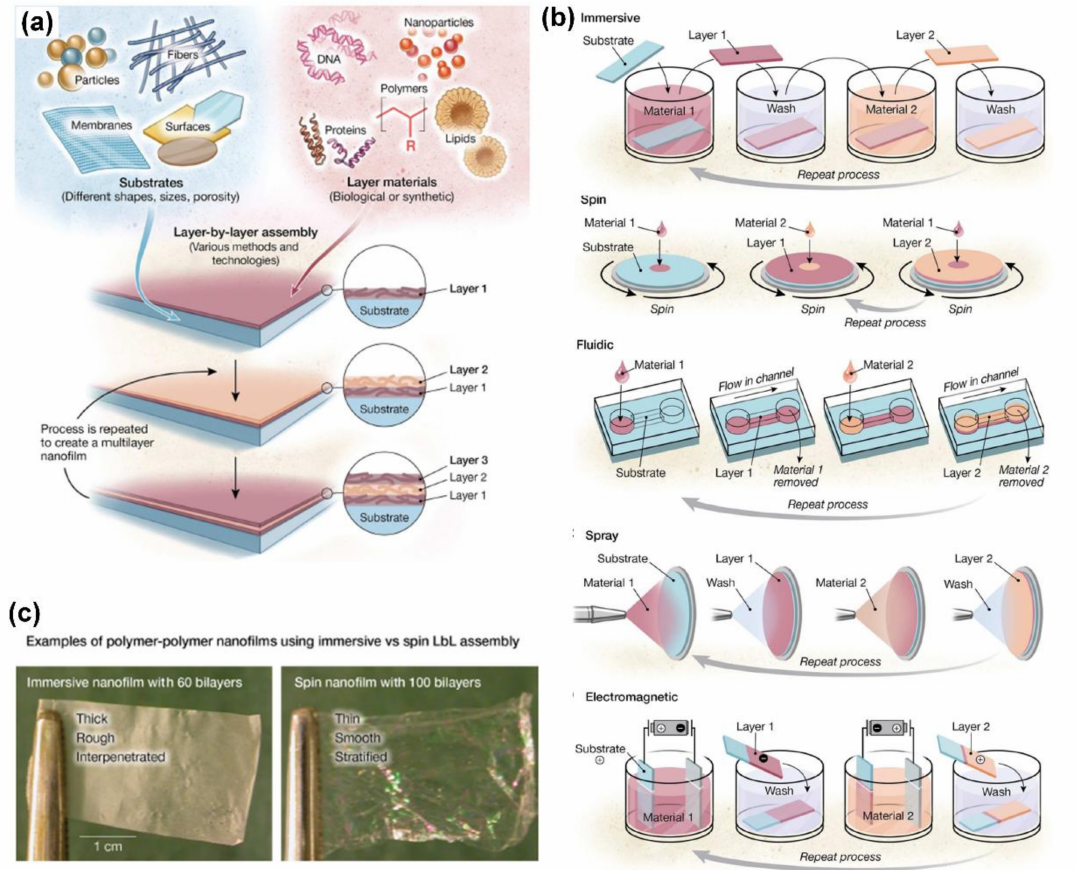
Figure 1. ( a ) Schematic overview of LbL assembly technique with fabrication capacity on any type of substrates and from an extensive choice of materials; ( b ) schematics showing the five main technology categories for LbL assembly; ( c ) a typical comparison of different films using immersive and spin assembly. Reprinted from [17] with permission from American Association for the Advancement of